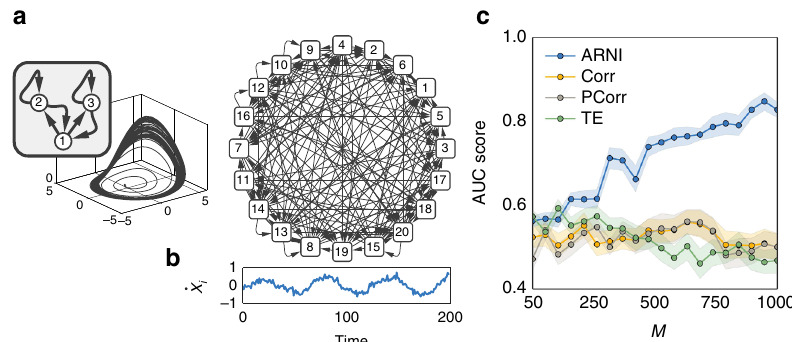
Fig. 3 Inferring interactions from noisy and chaotic dynamics. Reconstruction of chaotic oscillator networks of N = 20 and n i = 5 incoming interactions. a Rössler oscillators themselves constitute subnetworks of three interconnected units. b Example of noisy derivatives in a Rössler oscillator. c Quality of reconstruction from transient trajectories with respect to M = S × m with m = 10, using our approach (ARNI), correlations (Corr), partial correlations (PCorr), and transfer